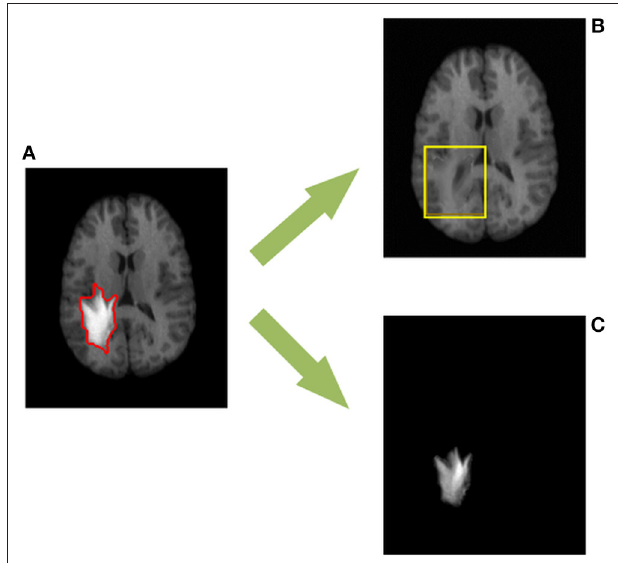
FIGURE 1 | The proposed TLS 2 D method can decompose (A) the MR brain tumor image into (B) the recovered MR image with quasi-normal brain appearances, and (C) the extracted tumor region. The red contour in (A) indicates the manually delineated tumor boundary. The yellow box in (B) indicates the reliably recovered